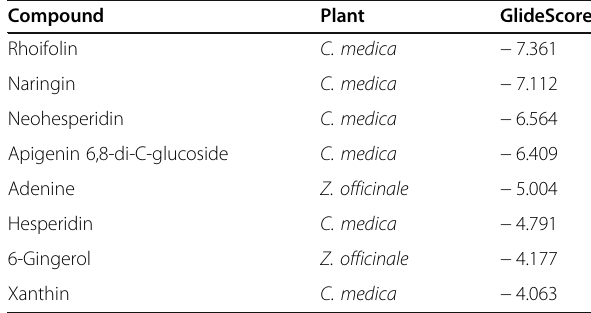
Table 1 Molecular docking results of the COVID-19 spike protein and the ligands from the Ayurvedic preparation [4]